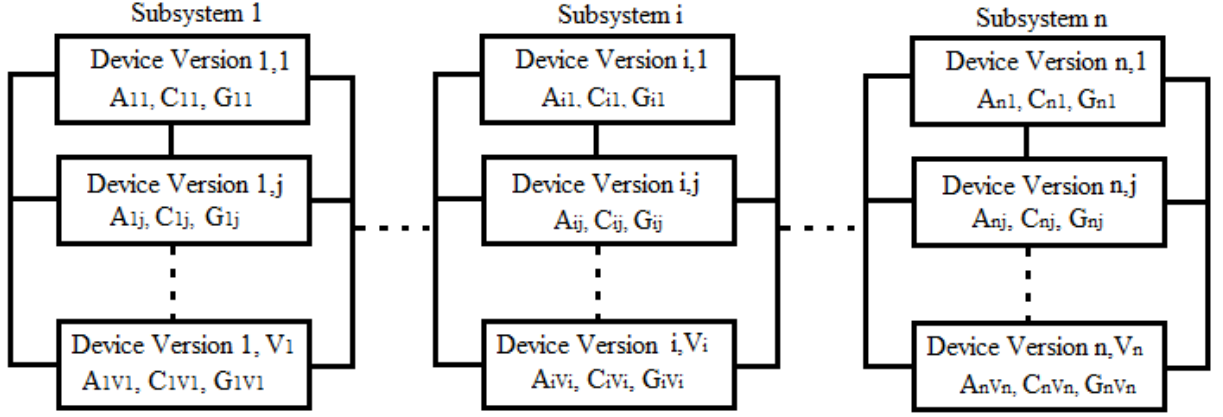
Figure 1. Series-parallel structure system.